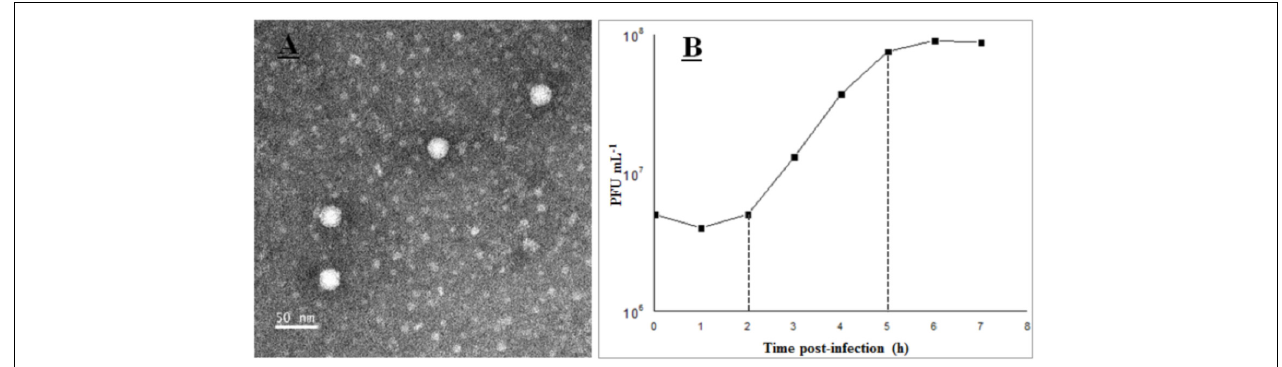
FIGURE 1 | Transmission electron microscopy images (A) and one-step curve (B) of phage vB_Cib_ssDNA_P1.